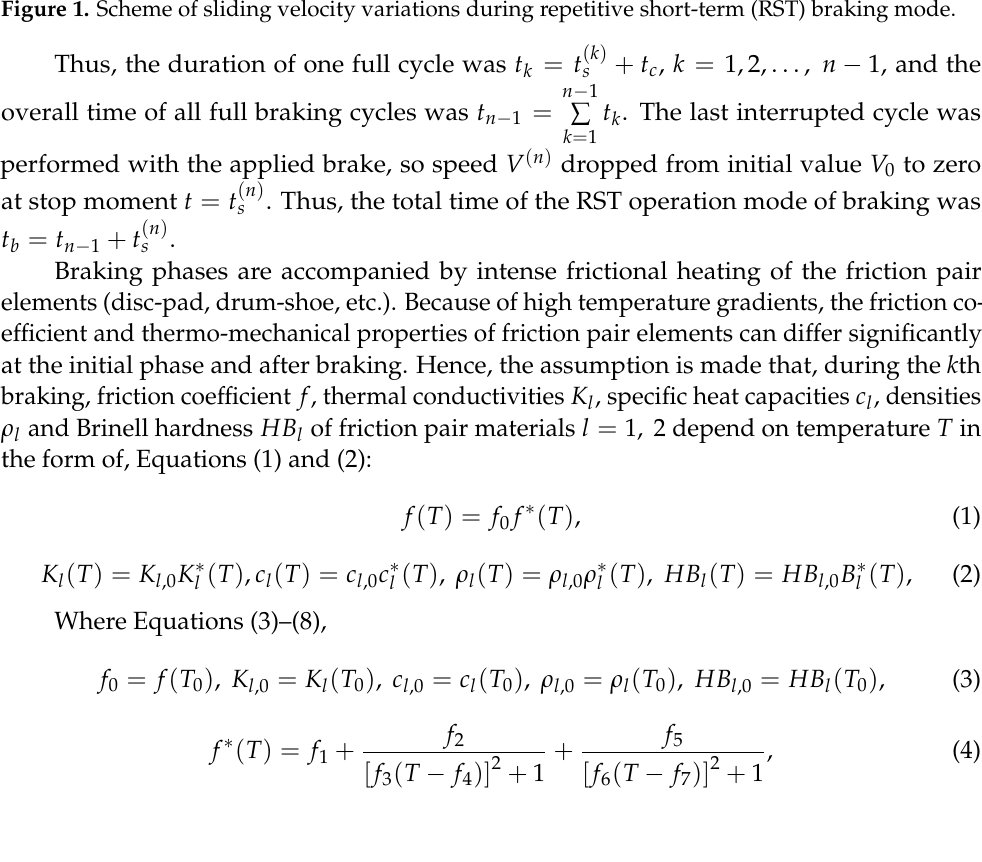
( k ) + t = 1, 2, . . . , n − 1, and the c , k s n − 1 ∑ t k . The last interrupted cycle was k = 1